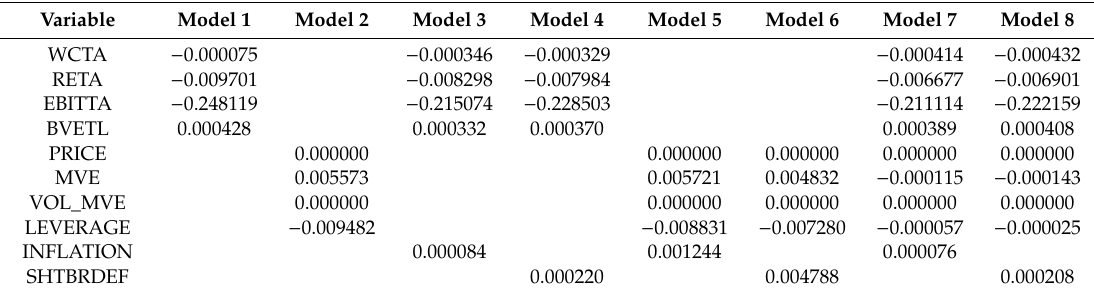
Table A3. Marginal e ff ect post crisis, 2007–2009.